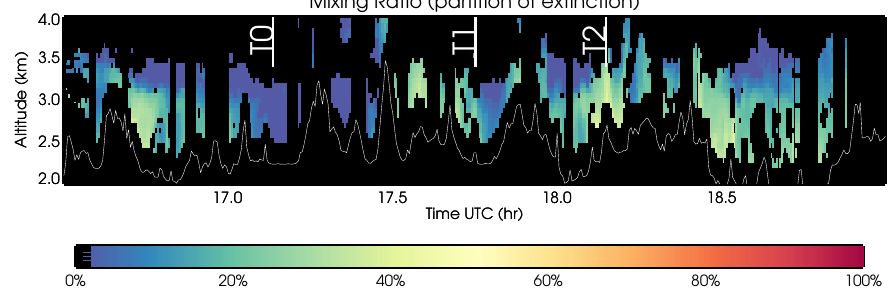
Fig. 4. Illustrates the extinction mixing ratio (percentage of 532nm extinction due to dust) for the dust plus urban mixtures observed by HSRL-1 on 15 March 2006 during the MILAGRO field campaign. The extinction mixing ratio is inferred from the lidar measurements and Eqs. (30)–(32) as described in the text. The blue end of the color scale indicates more urban and the red end indicates more dust. Vertical lines indicate the closest approach to the three campaign ground sites, T0, T1 and T2.